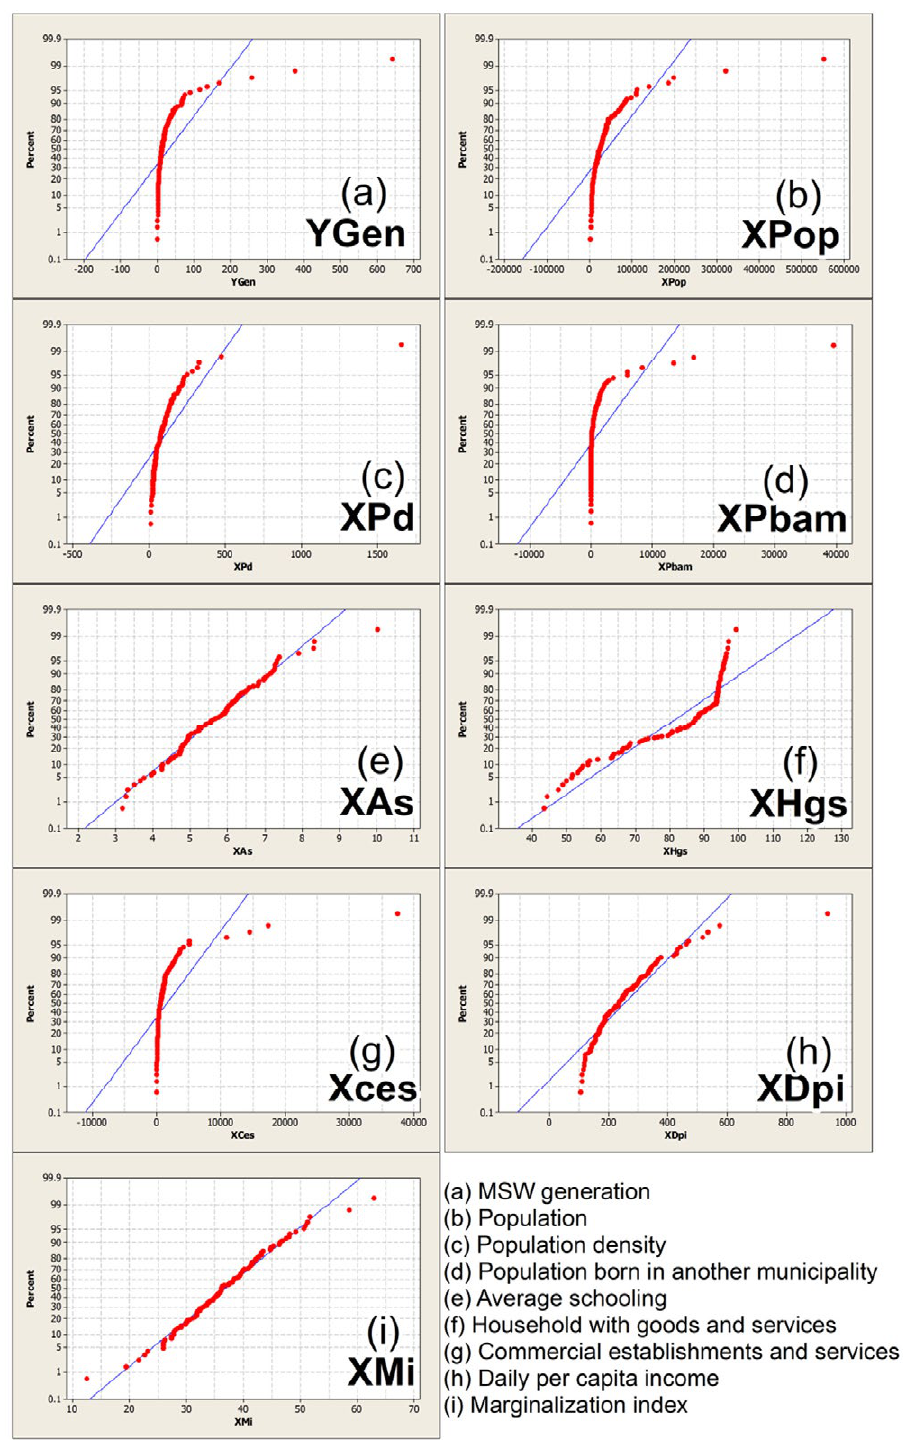
Fig. 3: Behavior of the variables analyzed with respect to normality